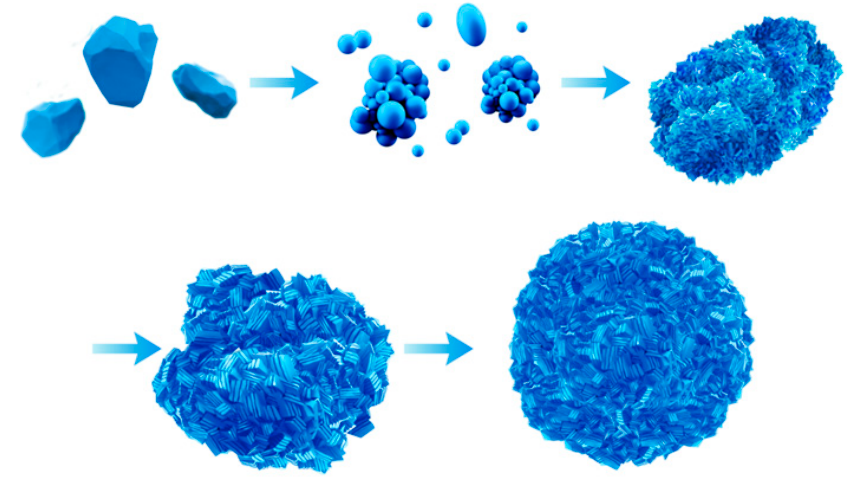
Figure 9. Agglomeration diagram of secondary particles.